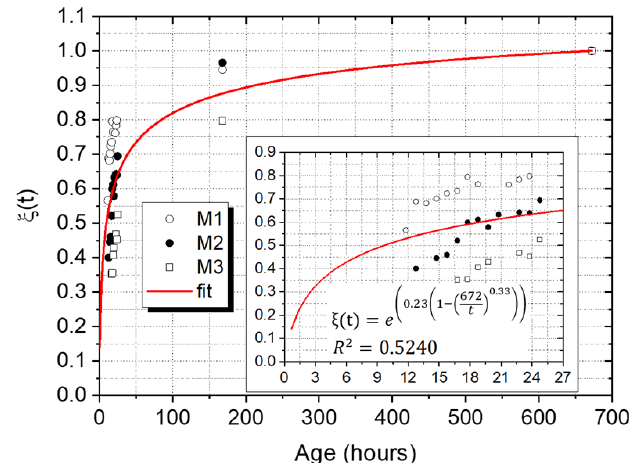
Figure 6 – Variation in the normalized rebound number over